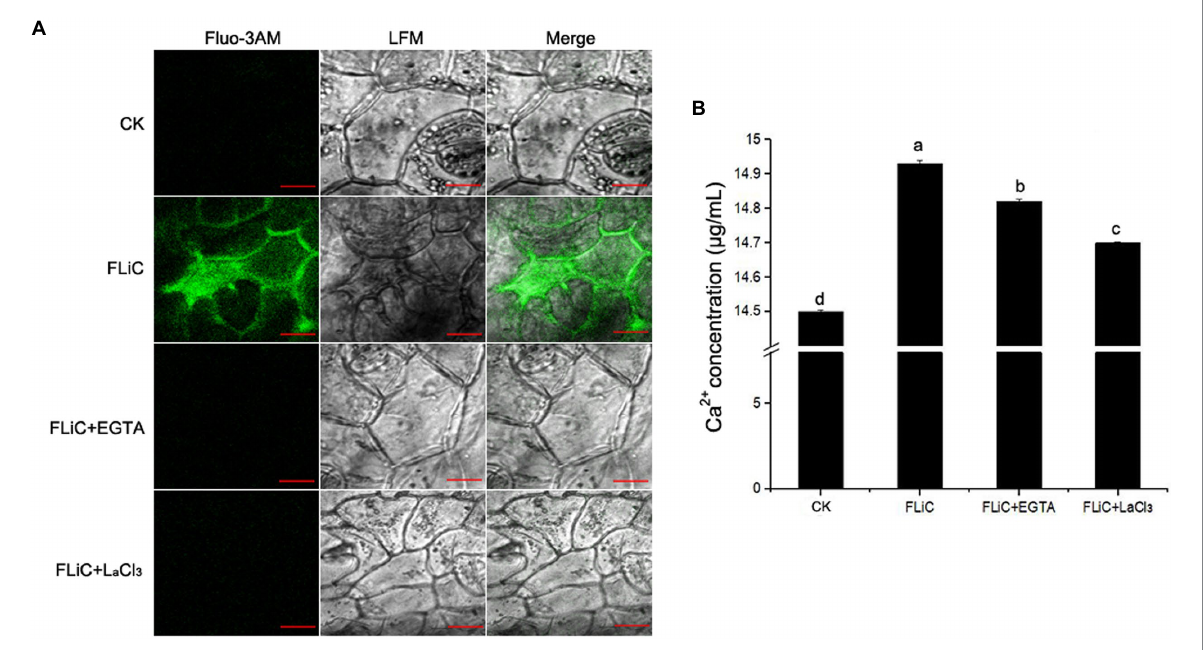
FIGURE 4 FLiC induces Ca 2+ production in upland cotton epidermal cells. (A) FLiC induces increased intracellular Ca 2+ content. (B) Intracellular Ca 2+ quantification. The data represent the means ± SDs; n = 3. One-way ANOVA ( p < 0.05) followed by Duncan’s test was used for multiple comparisons. The different letters indicate significant differences at the 0.05 probability level. Bars = 50 μ